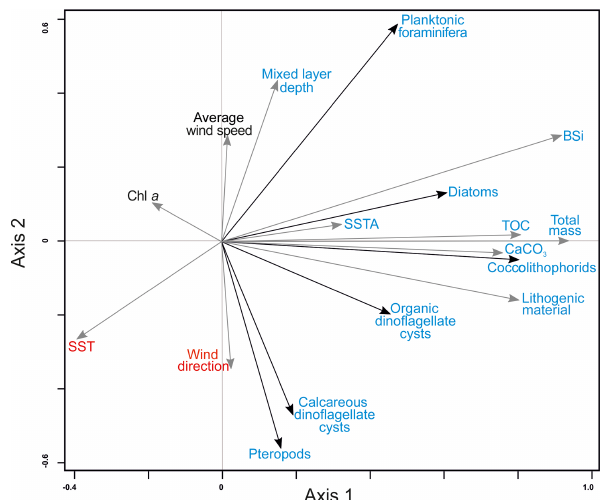
Figure 5. RDA ordination diagram depicting the relationship be- tween the accumulation rates of organism groups and bulk fluxes and environmental conditions in upper waters. References are given as follows. Av. wind speed: average wind speed; Chl a : chloro- phyll a ; TOC: total organic carbon; CaCO 3 : calcium carbonate; MLD: mixed layer depth; SST: sea surface temperature; SSTA: sea surface temperature anomalies. For interpretation of the references to color in this figure legend, the reader is referred to the web ver- sion of this